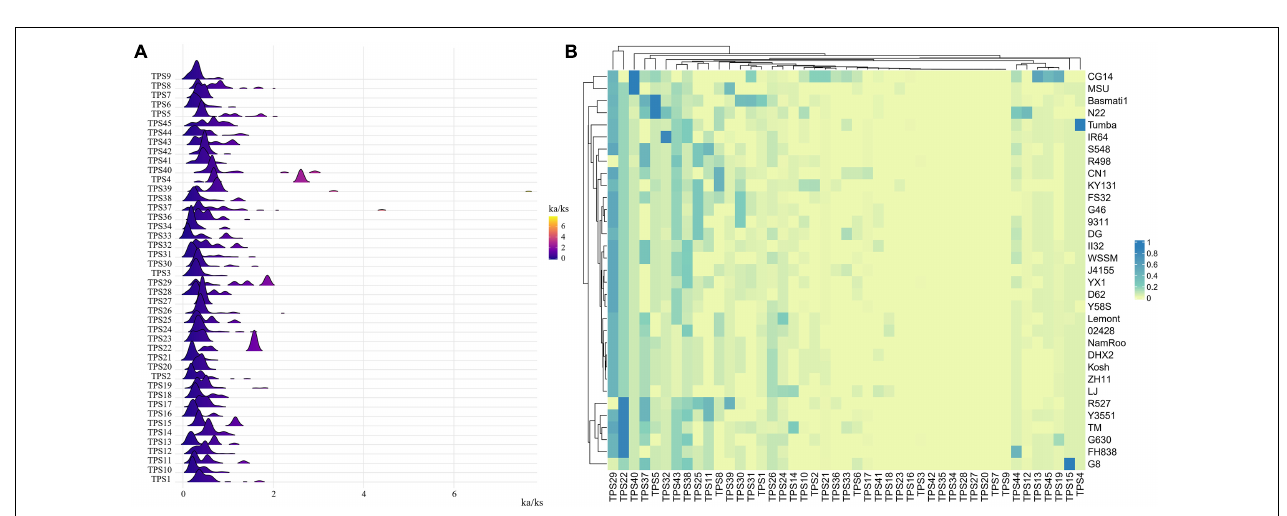
FIGURE 1 | (A) phylogenetic tree of TPSs from Arabidopsis and rice. OsTPSs are marked in blue and AtTPSs are marked in red. The circles and stars in front of the OsTPSs indicate variable genes (present in more than 1 but less than 33 accessions) and core genes (present in all accessions), respectively. (B) Heatmap showing variable TPS genes present or absent in the 33 accessions.